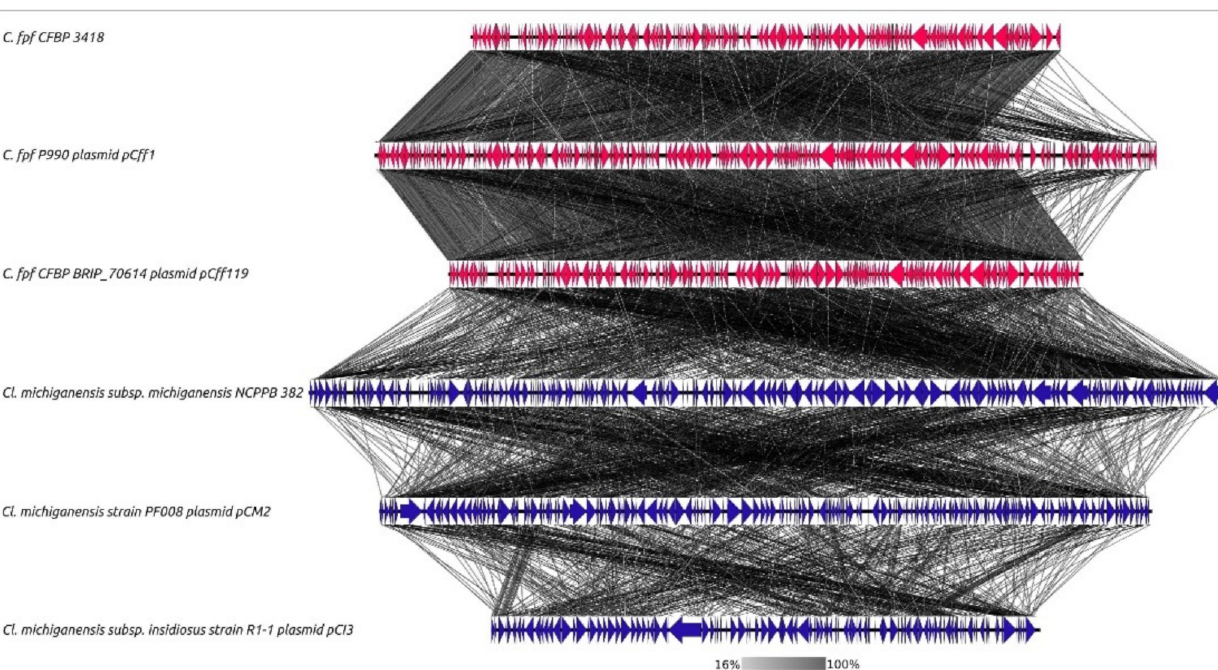
Figure 7. Genome sequence comparison among six Curtobacterium and Clavibacter plasmids and chromosome regions exhibiting co-linearity as detected by TBLASTX. The percentage of the sequence similarity is indicated by the intensity of the grey colour. Vertical blocks between analysed sequences indicate regions with at least 16% similarity. The abbreviations are as follows: C .— Curtobacterium